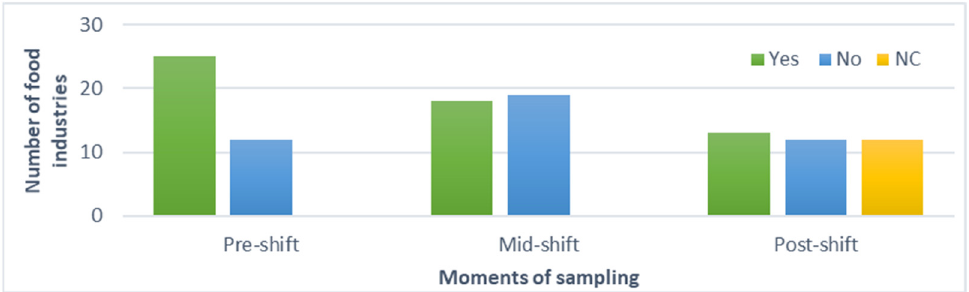
Figure 2. Sample collection moments identified by surveyed food facilities. The same agri-food industry can sample at different moments of the production cycle. NC: Not communicated.